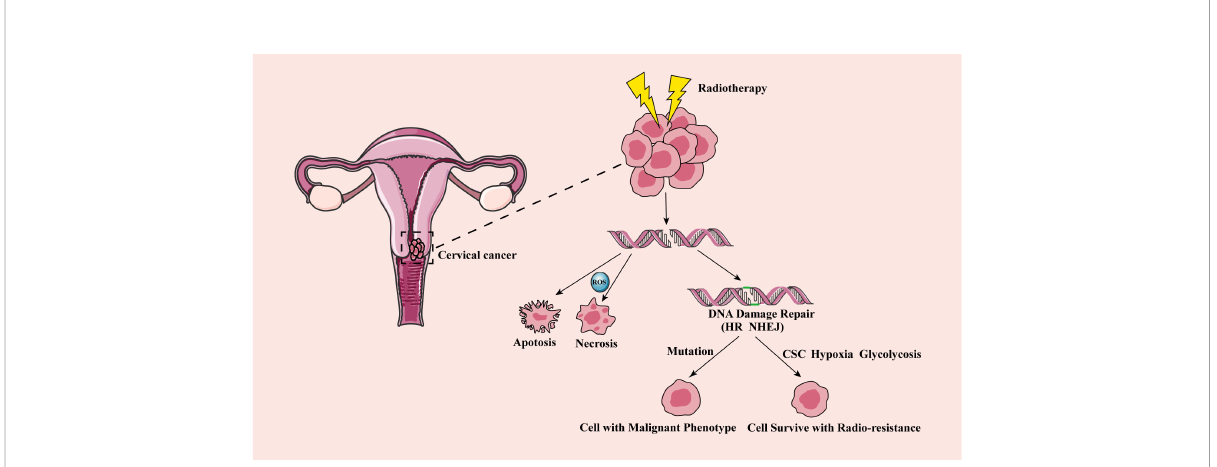
FIGURE 1 The mechanism of cervical cancer radioresistance after radiotherapy. After RT, DNA double strand breaks in cervical cancer cells, and some cancer cells show apoptosis and necrosis, reaching the effect of RT. Other fraction of cancer cells has DNA damage repair (including HR and NHEJ). The wrong repair path leads to the accumulation of acquired mutations, and tumor aggressivity and recurrence, while the correct repair leads to cell survival and radioresistance. CSC, cancer stem cell; HR, homologous recombination; NHEJ, non-homologous end joining; RT,